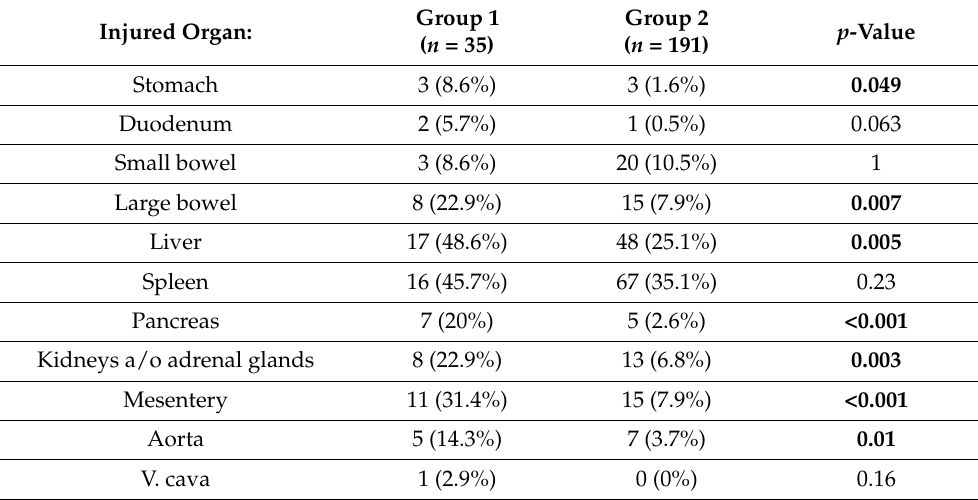
Table 3. Abdominal injury patterns among groups 1 and